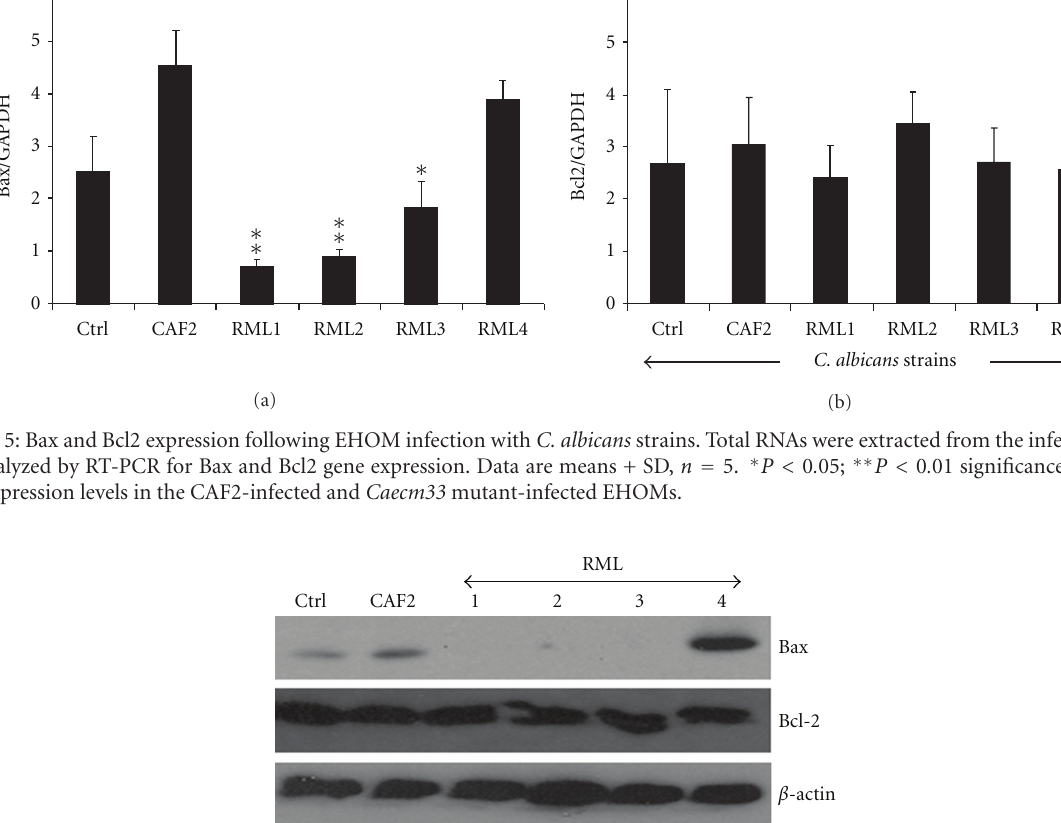
levels in the infected EHOM (Figure 7(b)) compared to the noninfected specimens. Thus ECM33 gene mutation did not prevent the laminin 5 and type IV collagen